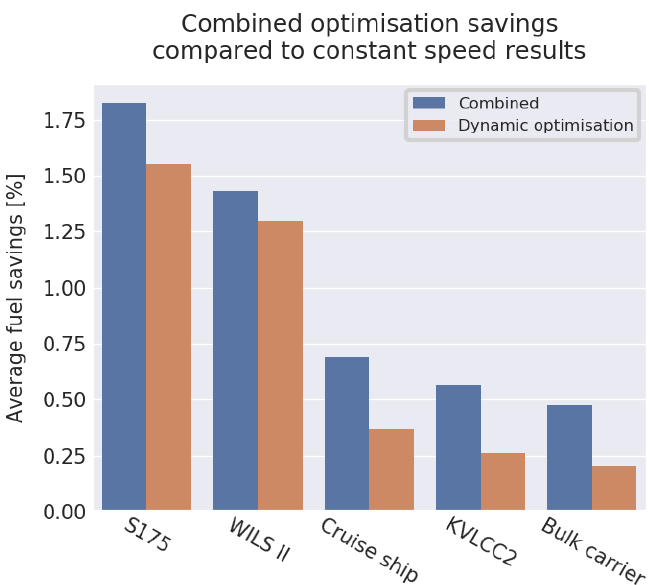
Figure 4. Comparison of attained fuel savings by ship type with the proposed combination of methods and dynamic optimisation, compared to fuel consumption with fixed speed along